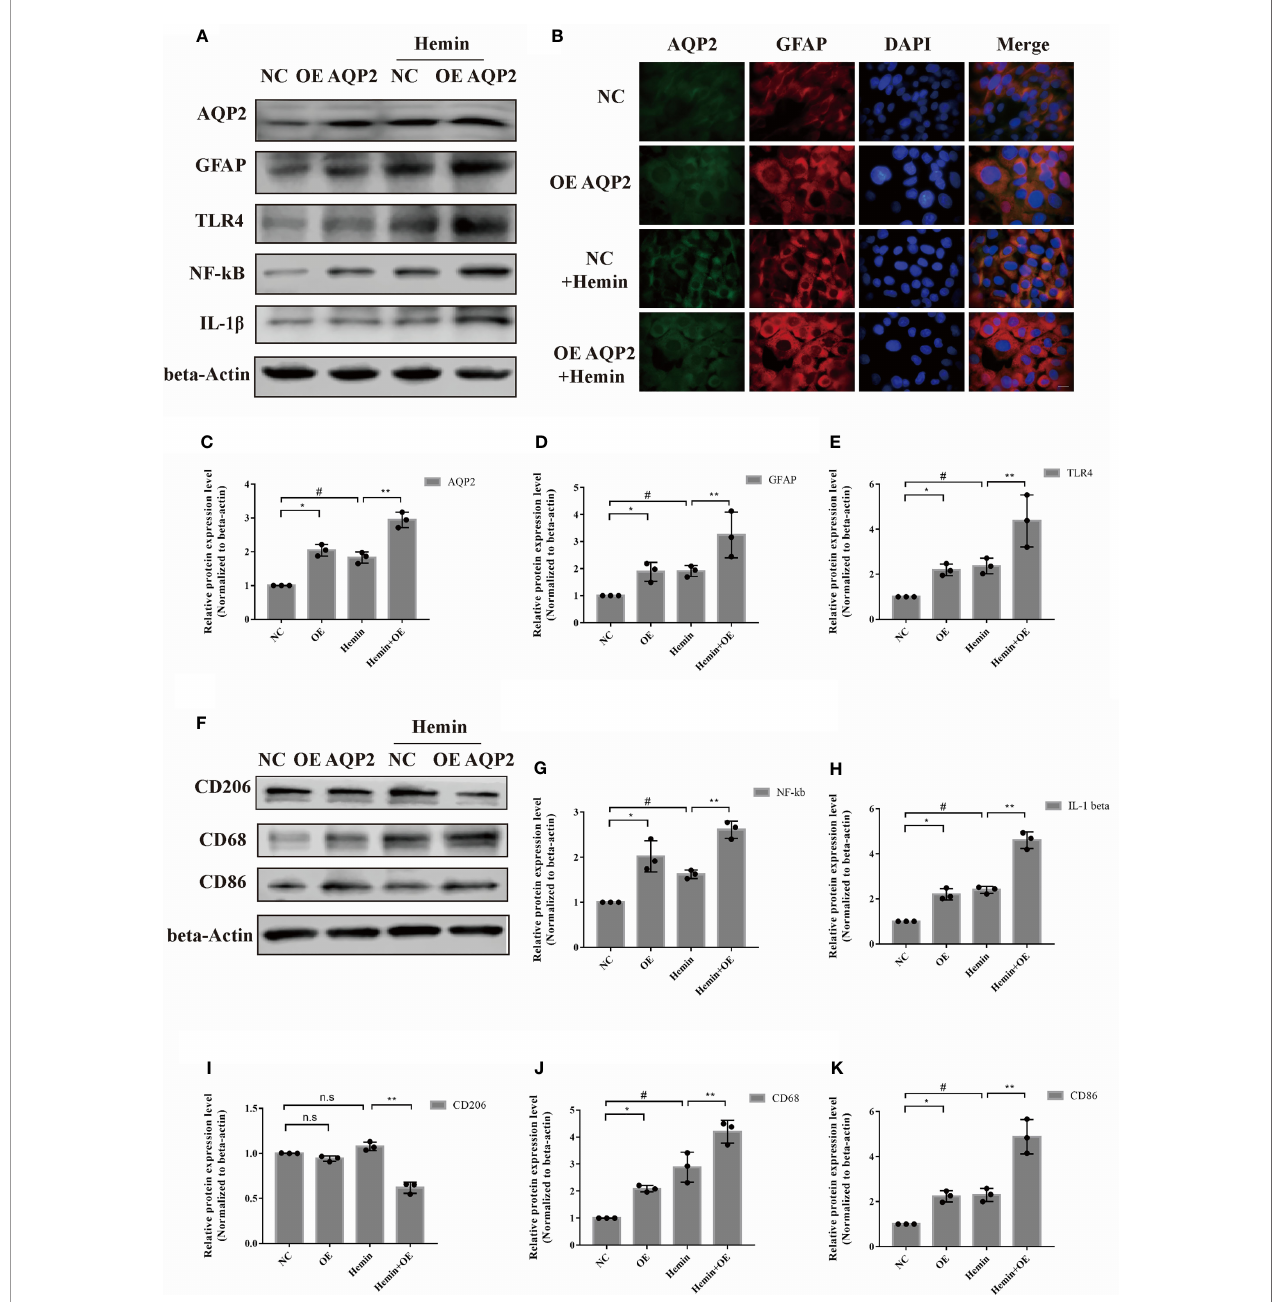
FIGURE 4 | AQP2 overexpression directly increases astrocyte activation and indirectly promotes microglia migration. (A) Astrocyte were transfected with pcDNA3.1 empty vector or pcDNA3.1-AQP2 plasmid, and AQP2, GFAP, TLR4, NF-kB and IL-1 b were assessed by western blotting (n = 3/group). (B) Immuno fl uorescence of AQP2 (red signal) and GFAP (green signal) in astrocyte with AQP2 overexpression or negative control (empty vector). Astrocyte cell nuclei were immunostained (blue, DAPI). Scale bar: 10 m m. (C, D) and (G, H) Quanti fi cation of the relative protein expression levels of AQP2, GFAP, TLR4, NF-kB and IL-1 b . (*p < 0.05 vs. empty vector group; **p < 0.05 vs. empty vector group exposed to hemin; # p < 0.05 empty vector group vs. empty vector group exposed to hemin). The data are presented as the mean ± s.d. of three independent experiments. (F) Microglia were treated with medium of astrocyte for 24h transfected with pcDNA3.1 empty vector or pcDNA3.1- AQP2 plasmid (with or without hemin). CD206, CD68 and CD86 were assessed by western blotting (n = 3/group). Quanti fi cation of the relative protein expression level of CD206 (I) , CD68 (J) and CD86 (K) is shown. (*p < 0.05 vs. empty vector group; **p < 0.05 vs. empty vector group exposed to hemin; # p < 0.05 empty vector group vs. empty vector group exposed to hemin). The data are presented as the mean ± s.d. of three independent